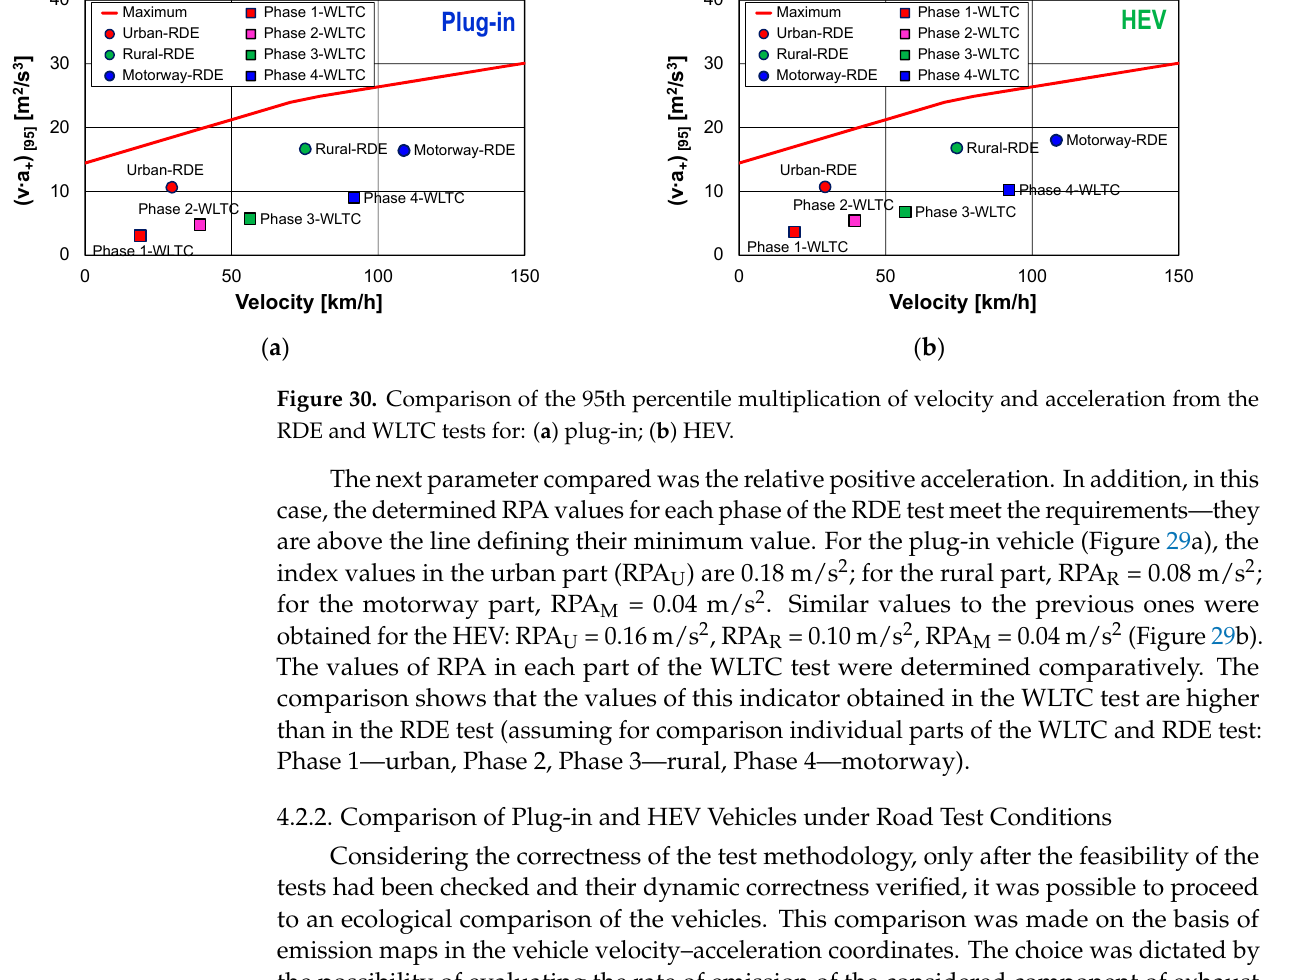
Figure 30. Comparison of the RPA rate in the RDE and WLTC tests for: ( a ) plug-in; ( b ) HEV.